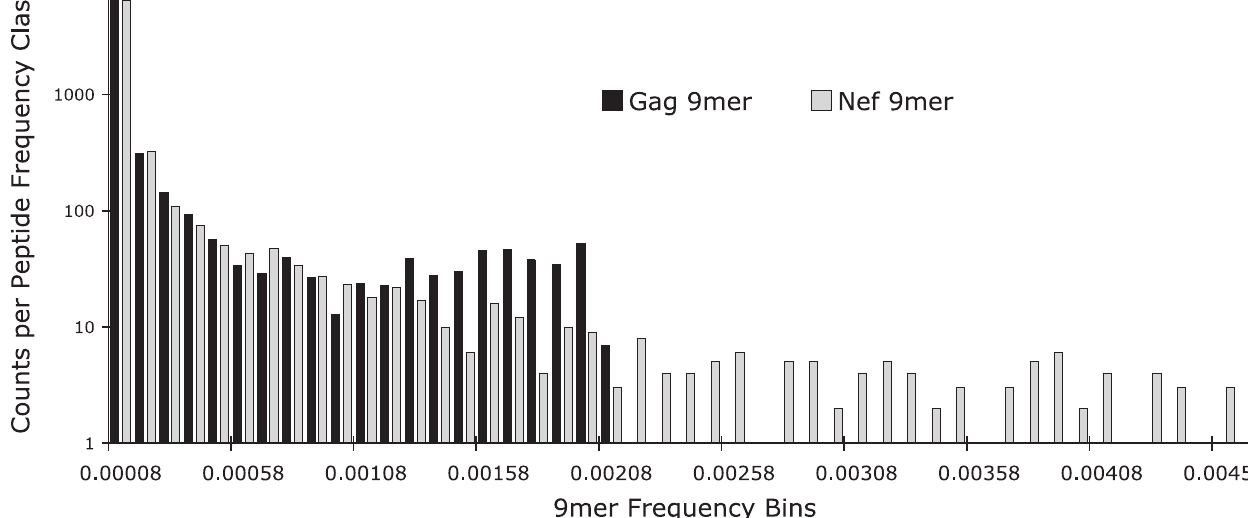
Figure 1. 9mer Peptide Distribution Derived from 169 HIV-1 Subtype B Gag and Nef Protein Sequences Each bin in the histogram represents the number of 9mers from a particular frequency class plotted on a log scale. There are only a few peptides found at high frequencies, whereas most of the 9mers occur only once or twice. The score of a given frame is the sum of the frequencies of each unique 9mer contained by the frame. The possible extreme value frequencies for each peptide from all rare to all common is 1.198 3 10 (cid:2) 5 (cid:2) 0.0020 for Gag (black bars) and 2.988 3 10 (cid:2) 5 (cid:2) 0.0051 for Nef (gray bars). The differences in the two distributions can be explained by the differences in gene length and levels of conservation.